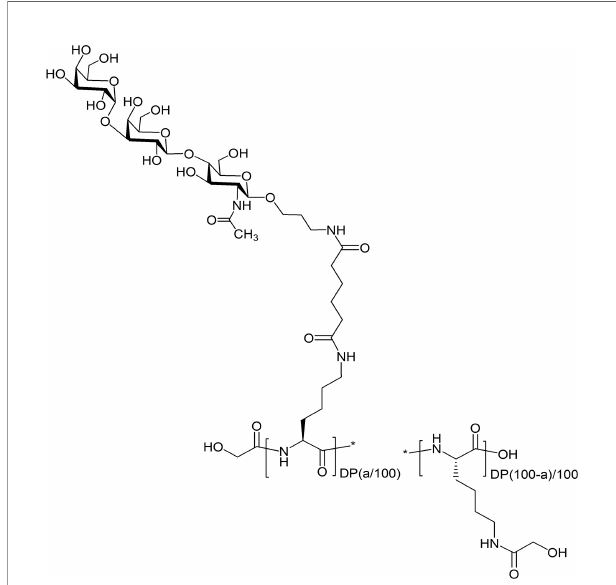
FIGURE 2 | General structure of polymeric a Gal-glycoconjugates. Poly-L- lysine backbone (degree of polymerization, DP: 100, 600, and 1000) were derivatized with the trisaccharide Gal a 1-3Gal b 1-4GlcNAc b -sp, (sp = -O(CH 2 ) fi cation with a Gal = a (9, 12, 18, 27 and 34%). 3 NH 2 ). Percent of modi Residual amino groups of poly-L-lysine were acylated with glycolic